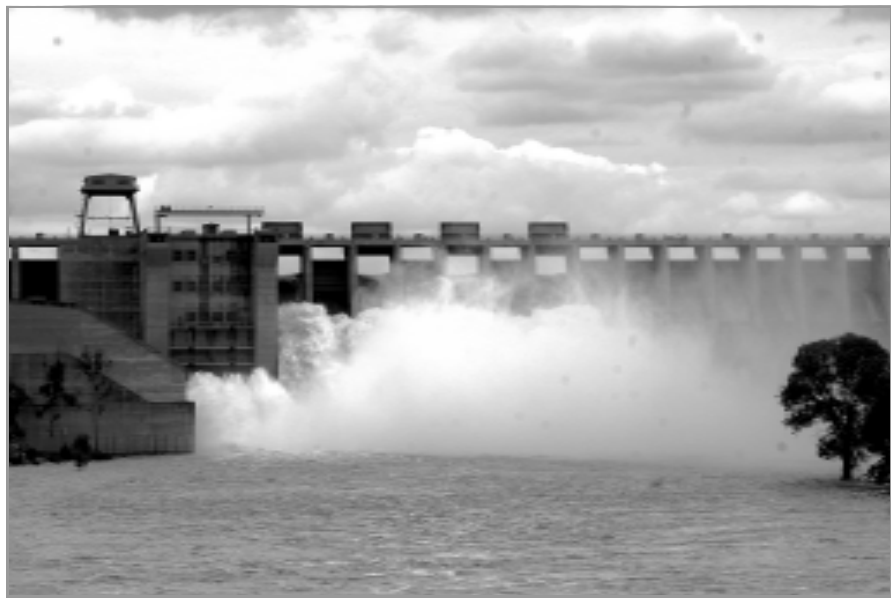
Illustration 4: The Vaal Dam at the time of the floods of 2006.